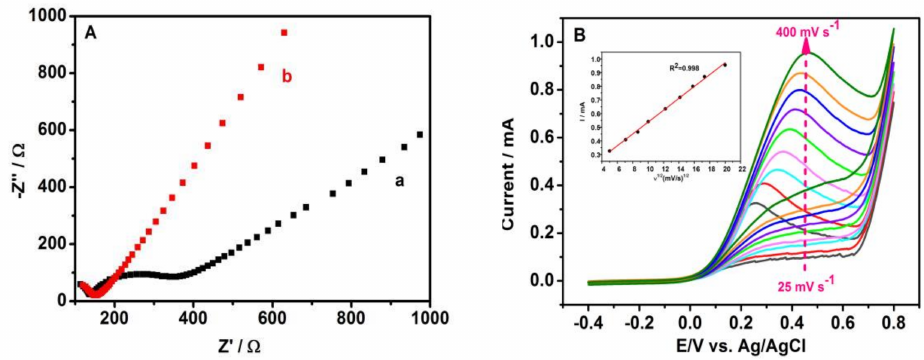
Figure 5. The Nyquist diagrams ( A ) of bare GCE (a) and CuO-400 / GCE(b), and CV curves ( B ) of CuO-400 / GCE at di ff erent scan rates (inset shows the linear relation of I ~ v 1 / 2 ).